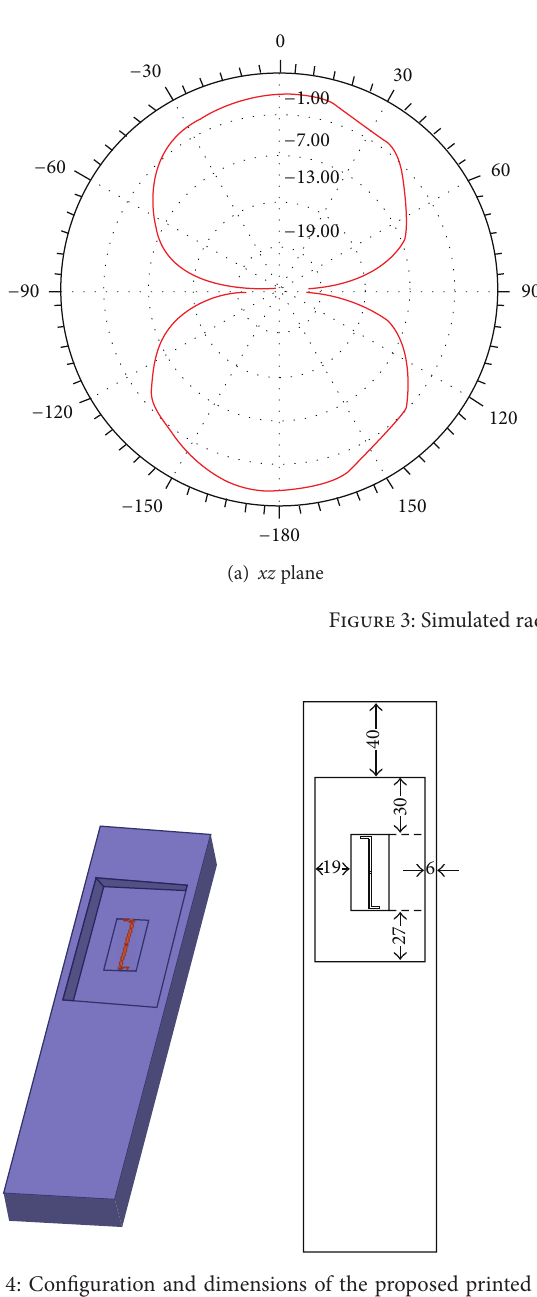
Figure 4: Configuration and dimensions of the proposed printed dipole antenna backed by an iron cavity (unit: mm).